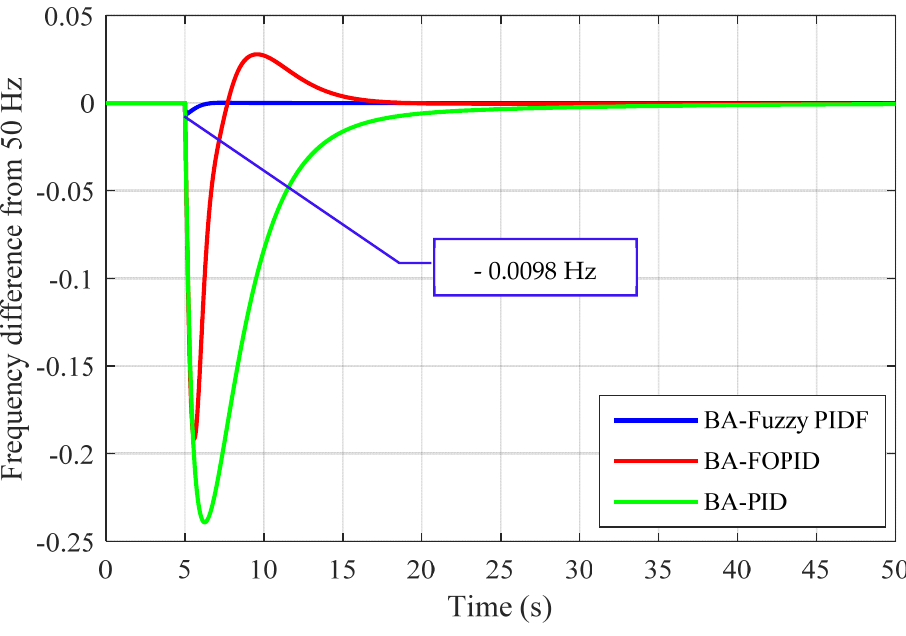
17 of 27 Figure 15. Comparison of three controllers tuned by BA based on ITAE for LFC of the GB system in the nominal scenario with 0.053 pu load disturbance. Table 18. Frequency response performances with BA-tuned controllers designed via minimizing ITAE in scenario 2 with 0.053 pu load disturbance.